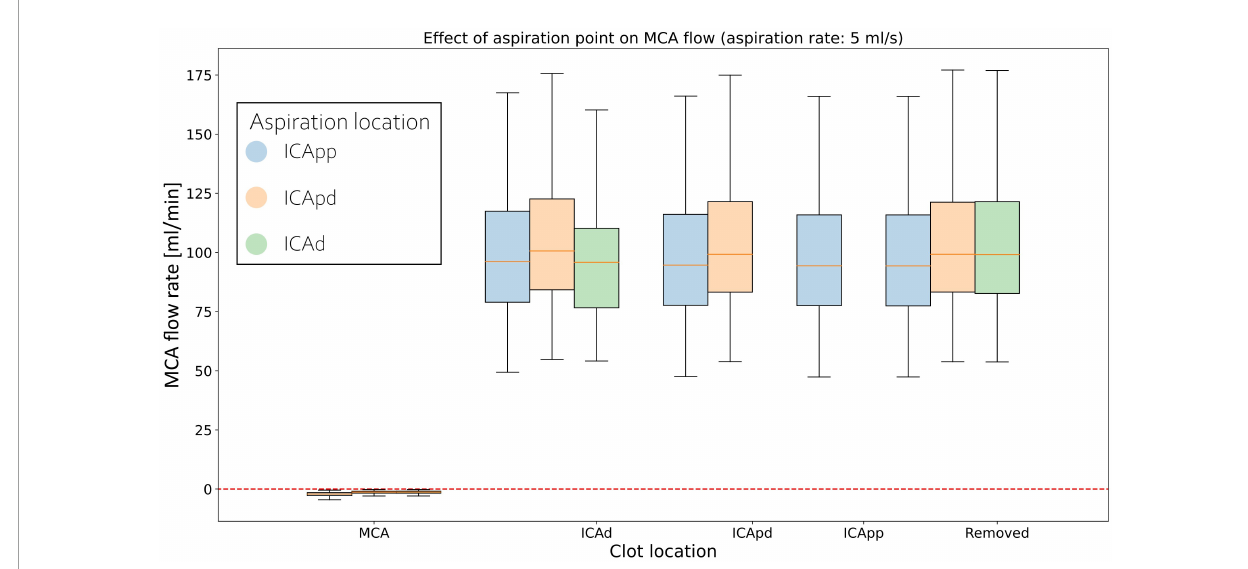
FIGURE6 Distributions of average MCA volumetric flow rate during clot retrieval, for three different positions of the aspiration catheter (ICApp, ICApd, and ICAd) when 5 ml/s aspiration is applied. BLUE: Aspiration in the proximal part of the proximal Internal Carotid (ICApp); ORANGE: Aspiration in the distal part of the proximal Internal Carotid (ICApd); GREEN: Aspiration in distal Internal Carotid (ICAd). The number of bars of a specific colour depends on the length of the retrieval path for the corresponding aspiration location (i.e., with aspiration in ICAd the retrieval path consists of MCA, ICAd, ICApd, and ICApd; with aspiration in ICAd the retrieval path consists only of MCA and ICAd).